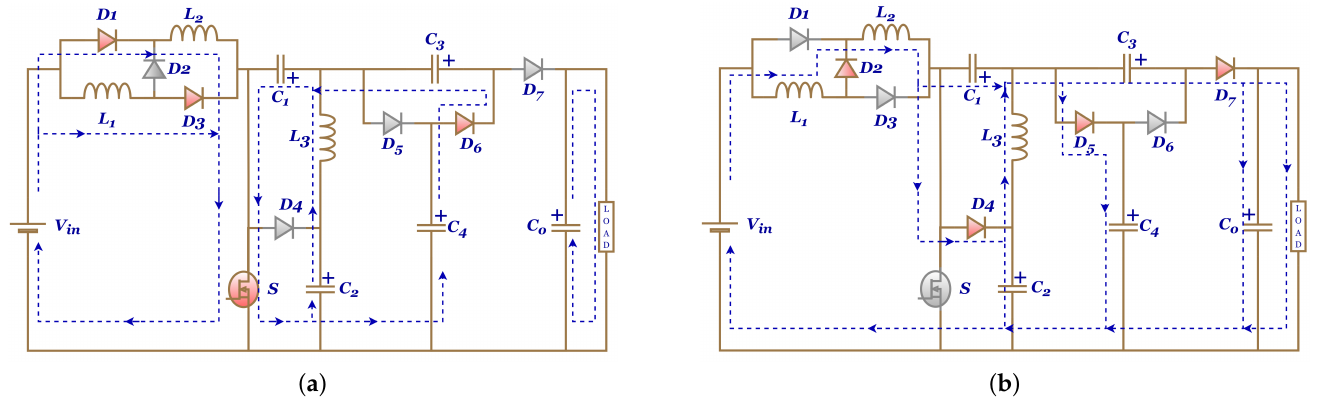
Figure 25. 4th M-SEPIC operations ( a ) S closed ( b ) S